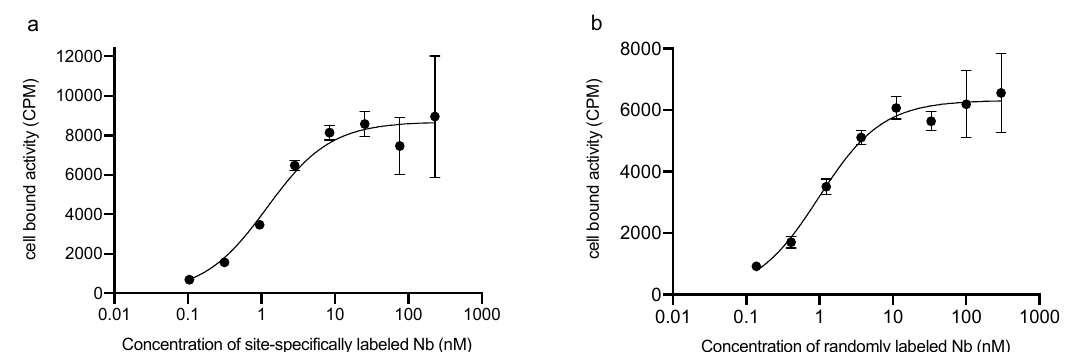
Figure 2. Radioligand binding study on PD-L1 POS 624-MEL cells. Cell bound activity in counts per minute (CPM) expressed as a function of the Nb concentration (nM) for ( a ) the site-specifically 68 Ga-labeled NOTA-(hPD-L1) Nb and ( b ) the randomly 68 Ga-labeled NOTA-(hPD-L1) Nb.